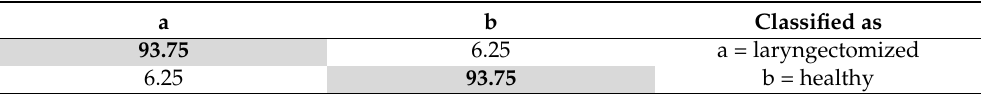
Table 5. Error matrix for the classification of the first phonetic segment. Used k-NN, cross-validation method (k = 10). General recognition 93.75%.